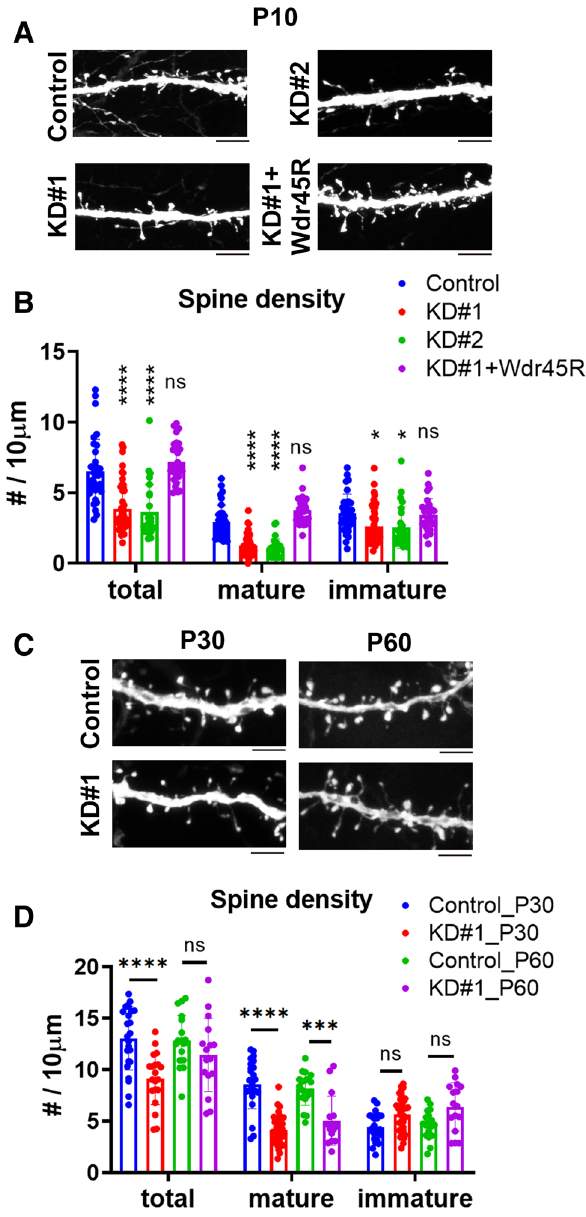
Figure 7. Effects of Wdr45-knockdown on the dendritic spine density and morphology in vivo. ( A ) pCAG- loxP-GFP was electroporated with pCAG-M-Cre together with pSuper-H1.shLuc (Control), pSuper-Wdr45#1 (KD#1), #2 (KD#2) or KD#1 plus pCAG-Myc-Wdr45R at E14.5. Coronal sections were prepared at P10 and stained for GFP. Representative images of dendritic spines on the 1st-order apical dendrites were shown. Scale bars, 5 μm. ( B ) Quantitative analyses of spine density and morphology (mature mushroom-shaped; immature filopodia-like or stubby spines) in layer II/III cortical excitatory neurons. One section from each brain was analyzed for control (n = 3), KD#1 (n = 4), KD#2 (n = 4) and KD#1 + Wdr45R (n = 5). Error bars indicate SD of the results from 20 to 30 neurons; * p < 0.05, **** p < 0.0001 by one-way ANOVA with Dunnett’s post hoc test (vs. control). ( C ) pCAG-loxP-GFP was co-electroporated with pCAG-M-Cre together with pSuper-H1.shLuc (Control) or pSuper-Wdr45#1 (KD#1) at E14.5. After fixation at P30 or P60, coronal sections were stained for GFP. Representative images of dendritic spines on the 1st-order apical dendrites were shown. Scale bars, 5 μm. ( D ) Quantitative analyses of spine density and morphology were performed as in ( B ). One section from each brain was analyzed for P30 (control, n = 5; KD#1, n = 6) and P60 (control, n = 4; KD#1, n = 5). Error bars indicate SD of the results from 20 to 30 neurons; **** p < 0.0001, *** p < 0.001 by one-way ANOVA with Tukey’s post hoc test (*vs